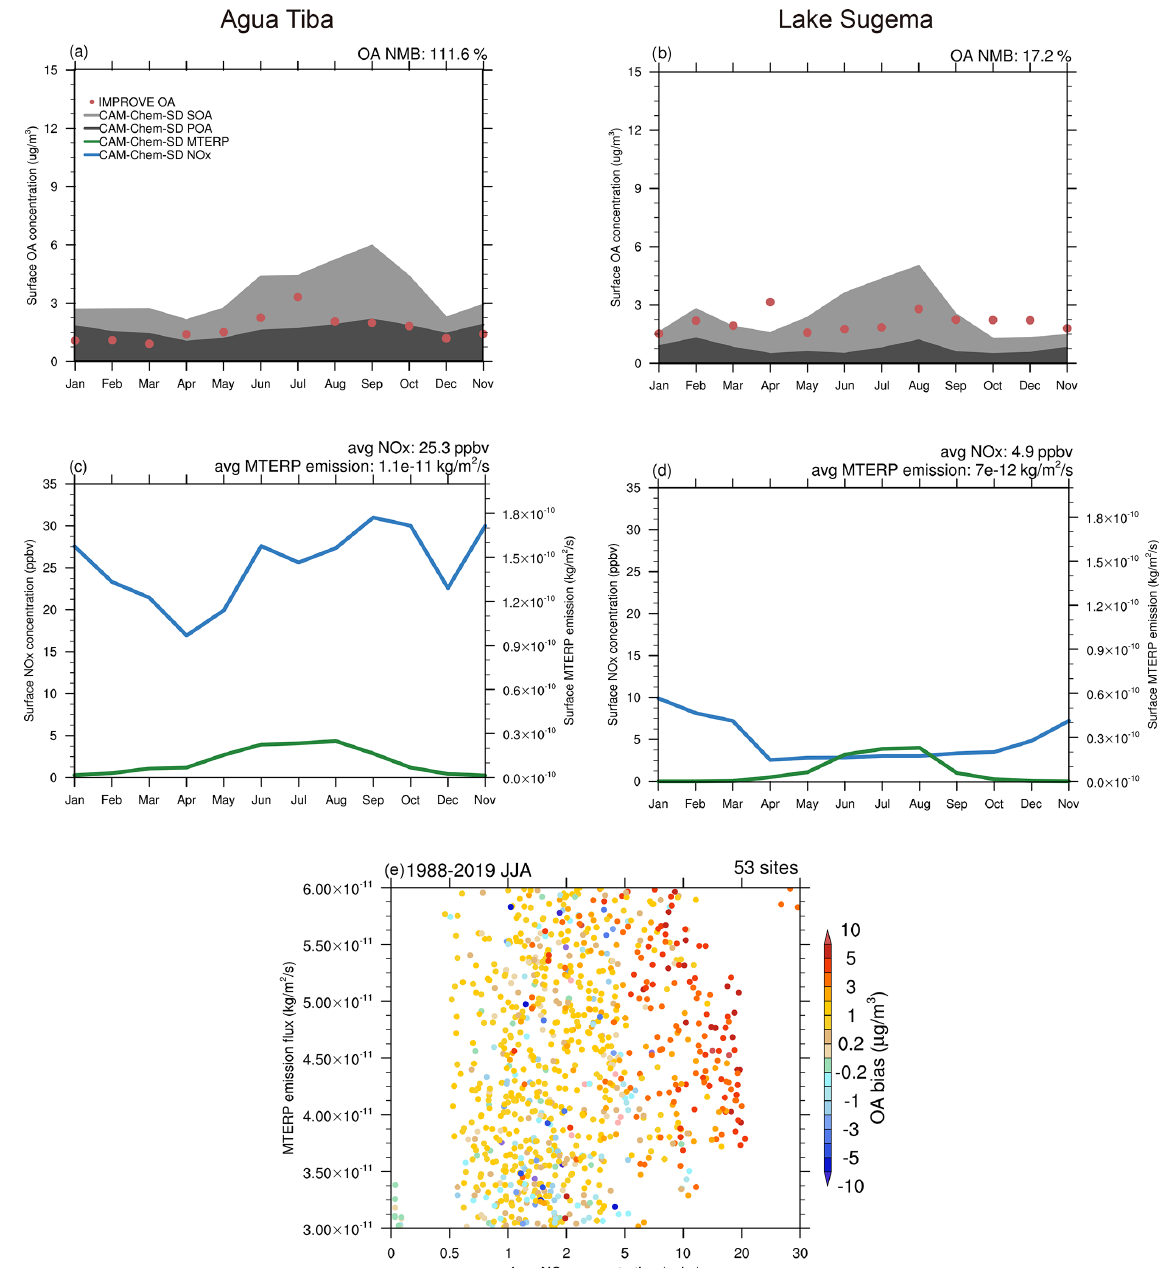
Figure 6. 2010 observed surface OA concentration (red dots) and simulated POA (dark filled area) and SOA (gray filled area) at the Agua Tibia site (33.5 ◦ N, 117.0 ◦ W) (a) and Lake Sugema site (40.7 ◦ N, 92.0 ◦ W) (b) ; simulated surface NO x concentration (blue lines) and MTERP emission from MEGAN (green lines) at the Agua Tibia site (c) and Lake Sugema site (d) . The 1988–2019 summertime surface OA bias (colorful dots) at specific NO x concentration and MTERP emission flux (e) over 53 sites where MTERP emission fluxes are between 3 × 10 − 10 and 6 × 10 − 10